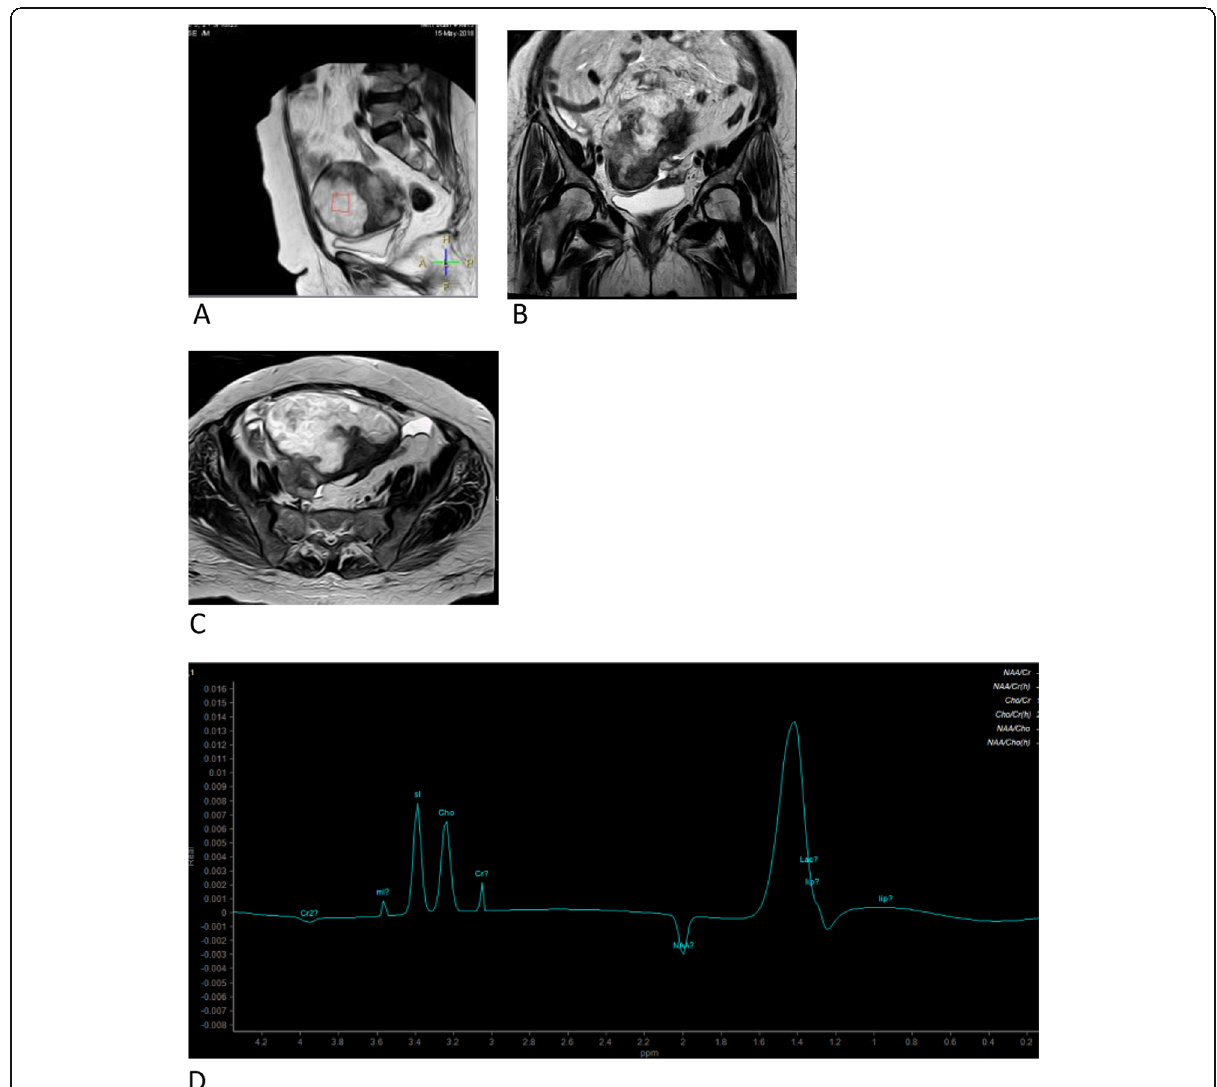
Fig. 2 A 58-year-old patient with left ovarian fibrothecoma with surgically proven torsion and infarction necrosis. a Sagittal T2-weighted images with voxel seen in the center of the lesion. b Coronal T2-weighted images with twisted vascular pedicle of the lesion (specific sign for torsion) c Axial T2-weightd images showing the fibrothecoma appearing as solid mass with cystic degeneration due to necrosis. Ascites is also noted. d MR spectroscopy showing choline peak with Cho/Cr ratio 3, with also sharp lipid peak